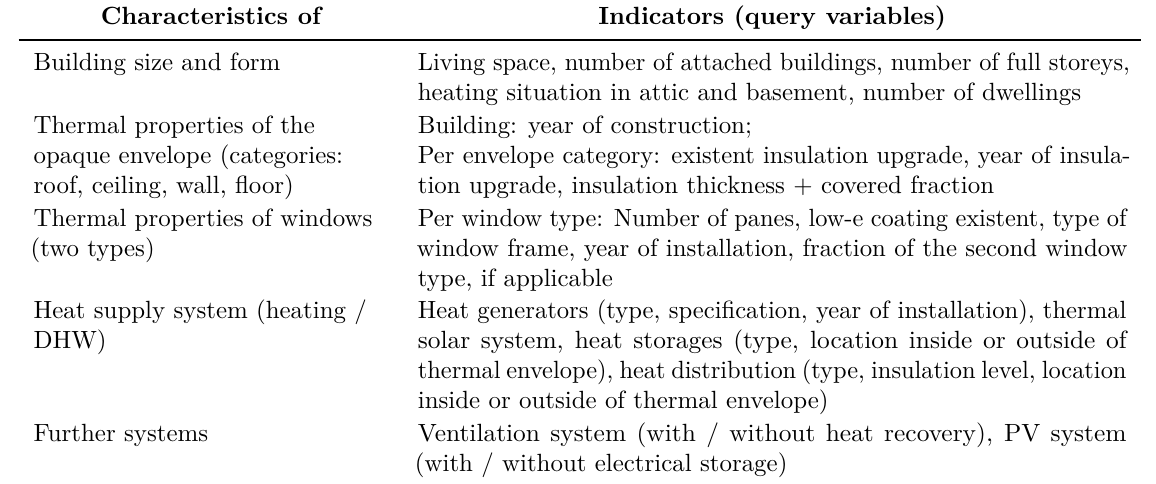
Table 1. Overview of energy profile indicators for residential